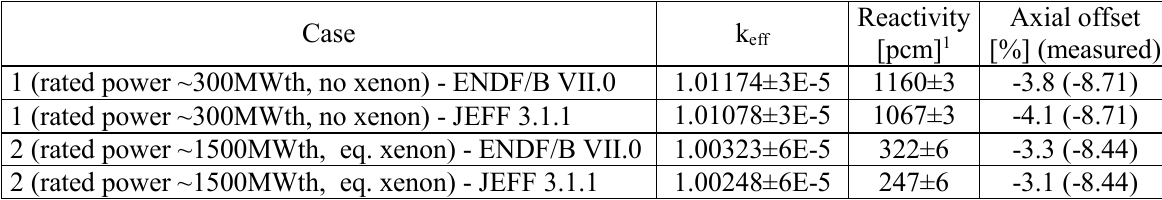
Table III: Main results for cases in Table